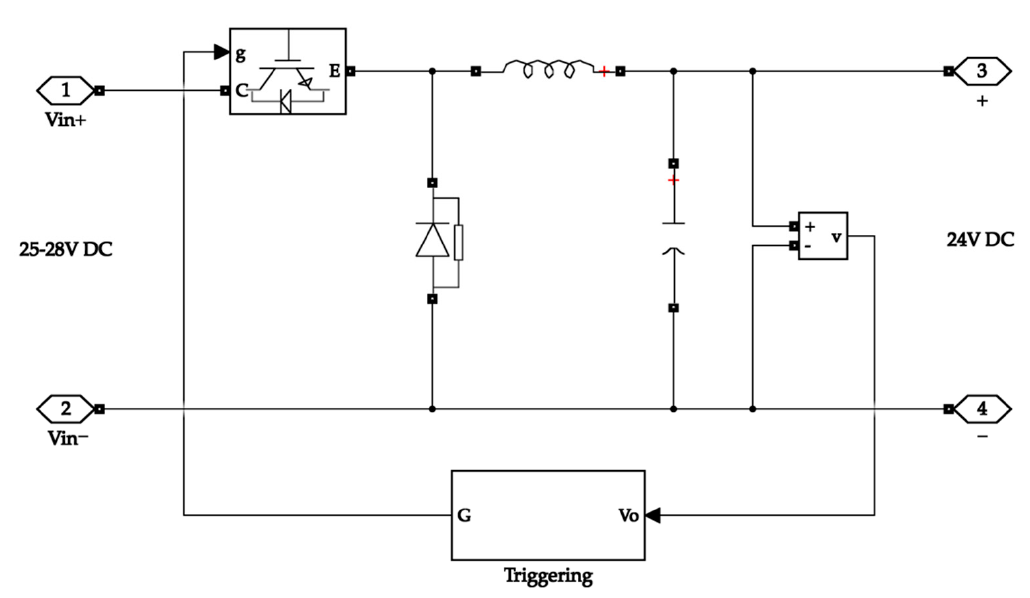
Figure 11. Buck converter on the output side.